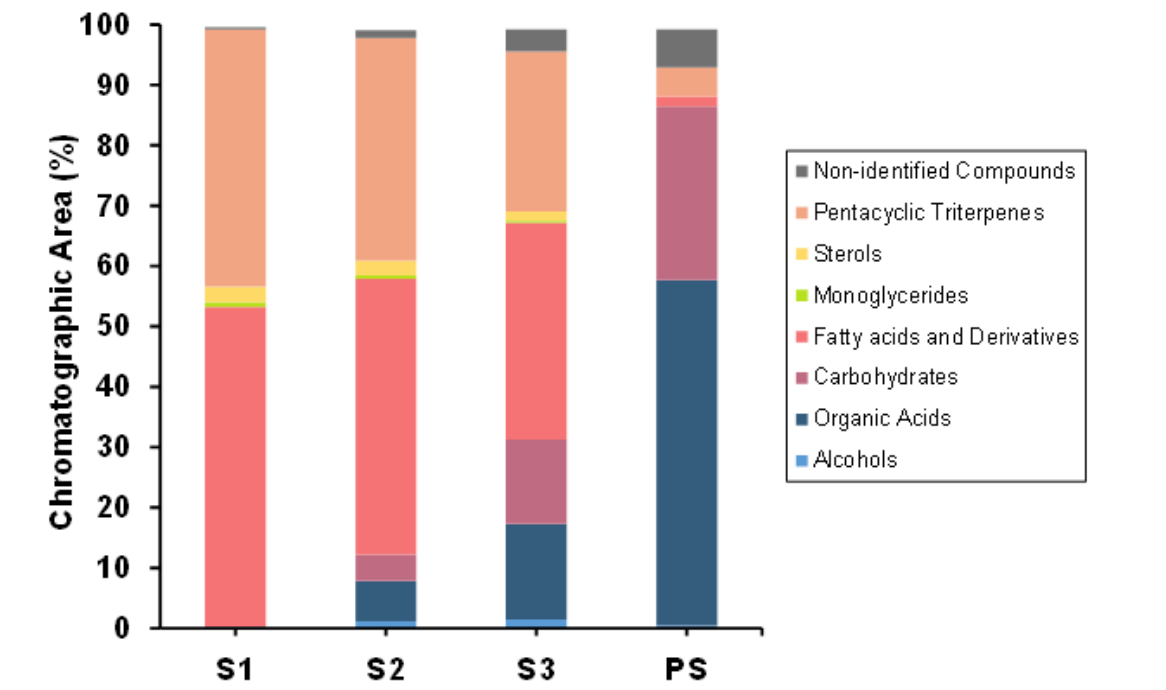
Figure 1. Chromatographic area (%) of each characterized family of compounds from S1, S2, S3, and PS supercritical extracts from MB.